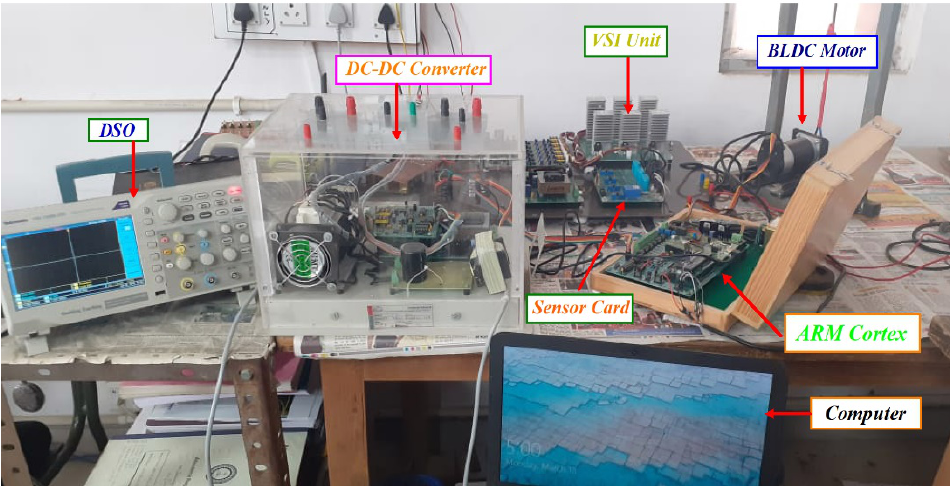
Figure 15. Experimental setup for BLDCM drive using an MSEPIC converter based on PWM ‐ MAC.